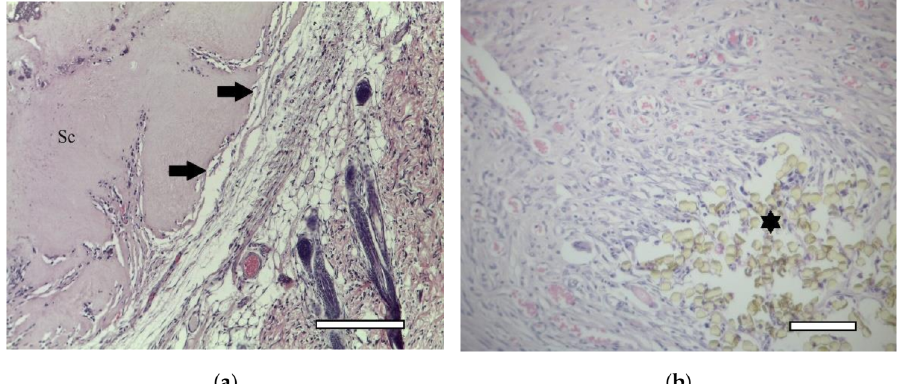
Figure 10. 1st group (dECM only), 2 weeks. Connective tissue capsule (arrows) around the scaffold (Sc). Staining with hematoxylin and eosin. ( a ) objective lens × 10, scale bar—200 µ m; ( b ) objective lens × 20, scale bar—100 µ m. In the lower right corner, the remains of suture material, which marked the site of the implantation (asterics).